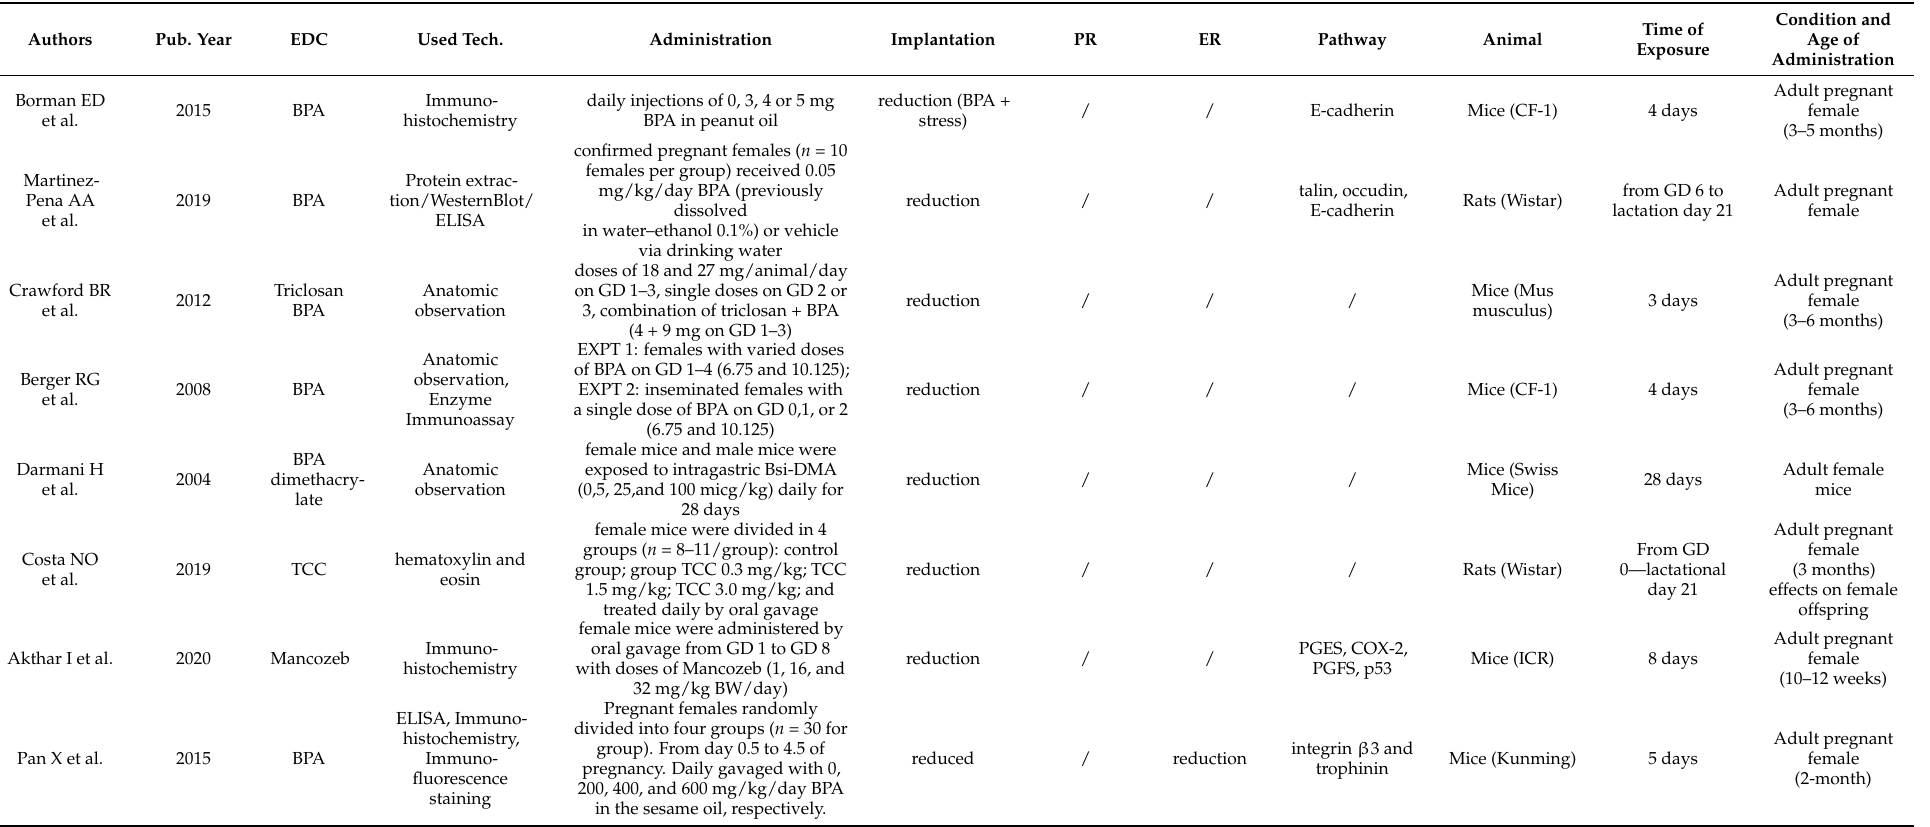
Table 2. EDC and Embryo Implantation